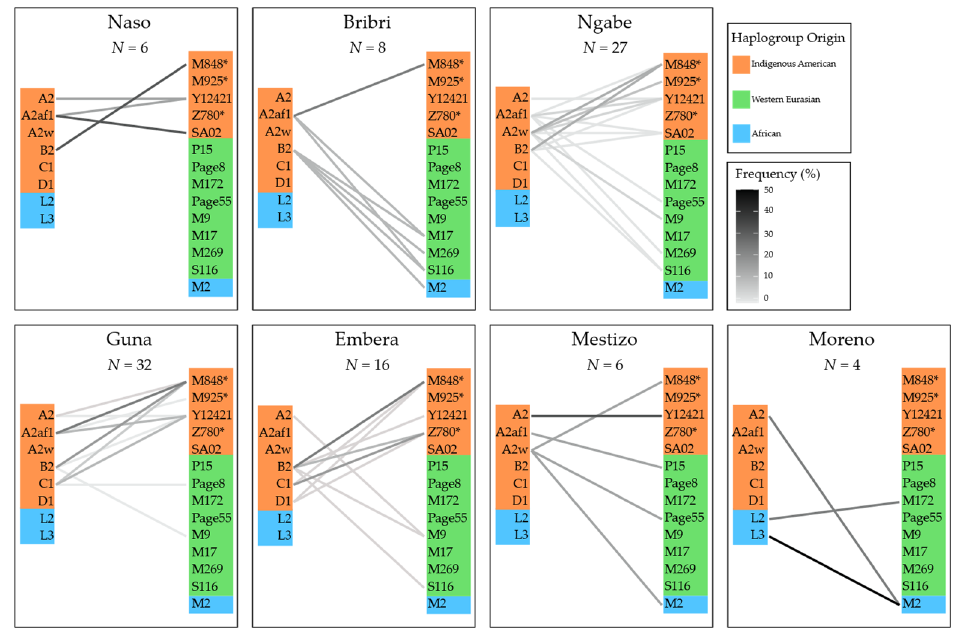
Figure 4. Heterogeneity based on haplogroup frequencies ( A ) and intra-population uniparental genetic pairwise distances ( B ) of different Panamanian groups computed for mtDNA and the Y-chromosome. In panel A, heterogeneity bars are shaded (from blue to red) according to the proportion of Indigenous lineages in each population. In panel B, dashed lines represent the mean value of all distances for mtDNA (above, mean = 0.12) and for the Y-chromosome (below, mean = 0.14).